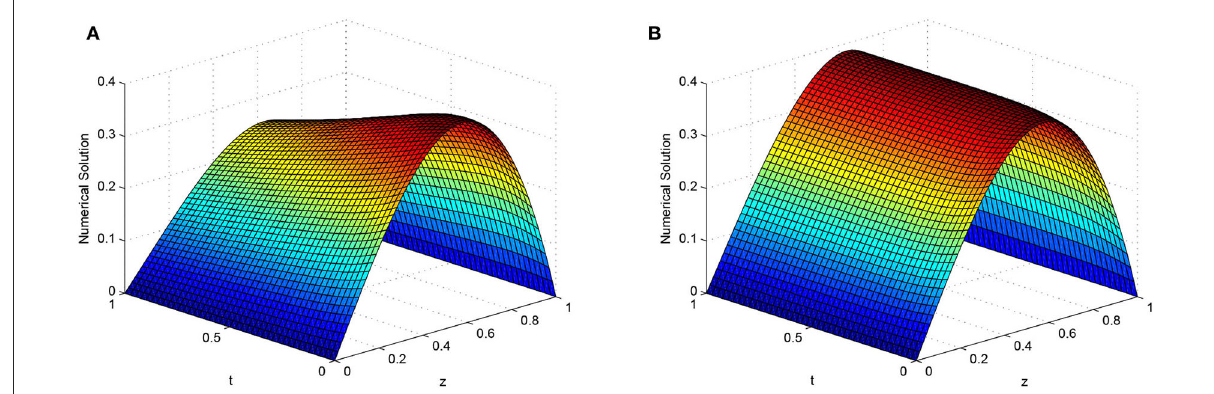
FIGURE1 Numerical solution for N = 64, M = 40, and ε = 2 − 18 (A) Example 5.1 and (B) Example